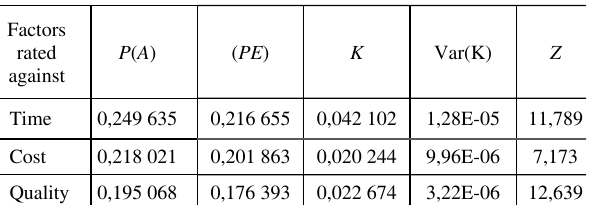
Table 3. Calculation of Z